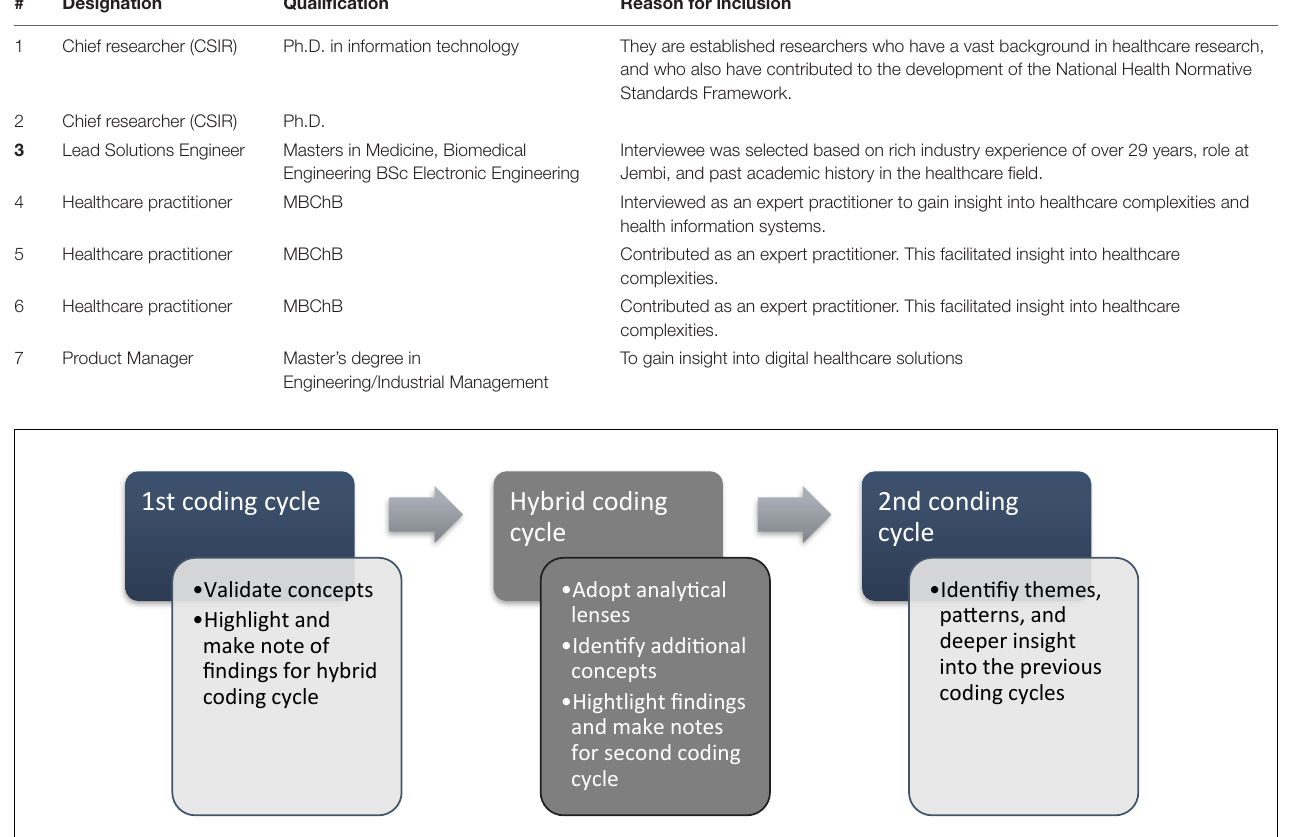
FIGURE 2 | Coding cycles of interview data (Saldaña,